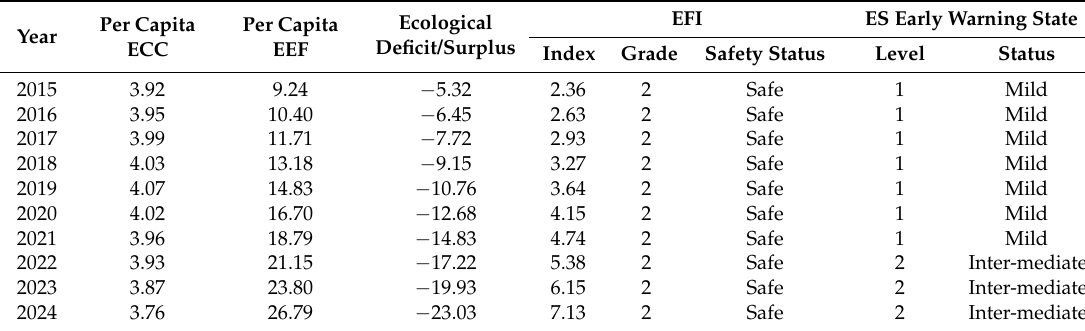
Table 2. ES evaluation and early warning